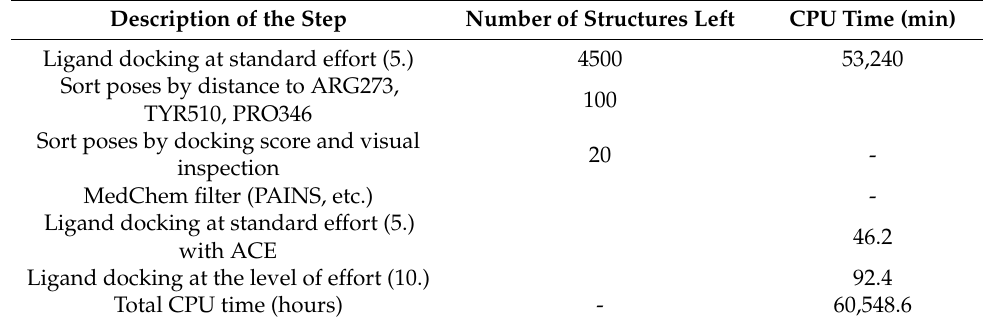
Table 4. Cont. Description of the Step Number of Structures Left Ligand docking at standard effort (5.)